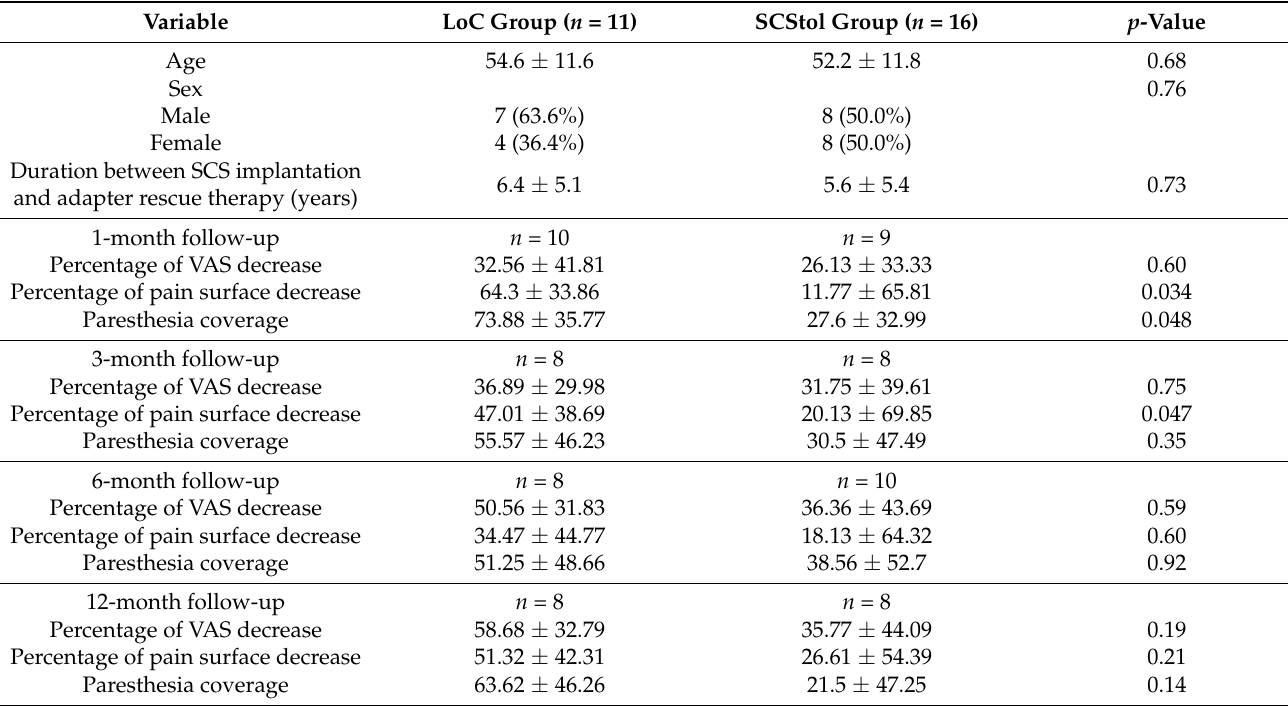
Table 4. Comparisons of percentage of pain intensity decrease, percentage of pain surface decrease and paresthesia coverage between the “loss of coverage” group ( n = 11) and the “SCS tolerance” group ( n =